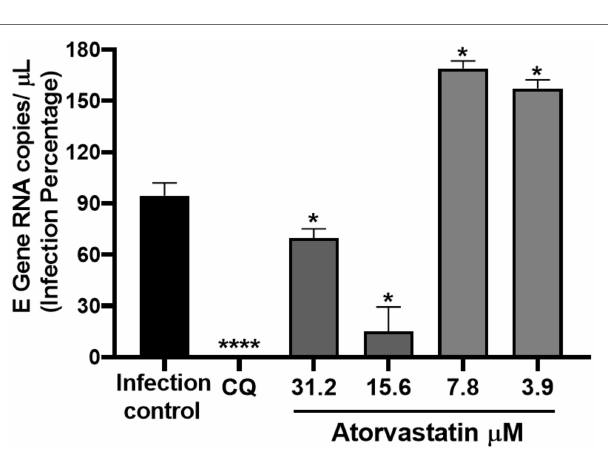
FIGURE 4 | ATV affected SARS-CoV-2 D614G replication. Infection percentage obtained of the quantification of SARS-CoV-2 RNA (E Gene RNA copies/ μ l) in Vero E6 monolayers after post-infection treatment with ATV. CQ was used as a positive control of viral RNA inhibition ( n = 4). Student’s t -test or Mann–Whitney U test * p ≤ 0.05 and **** p <